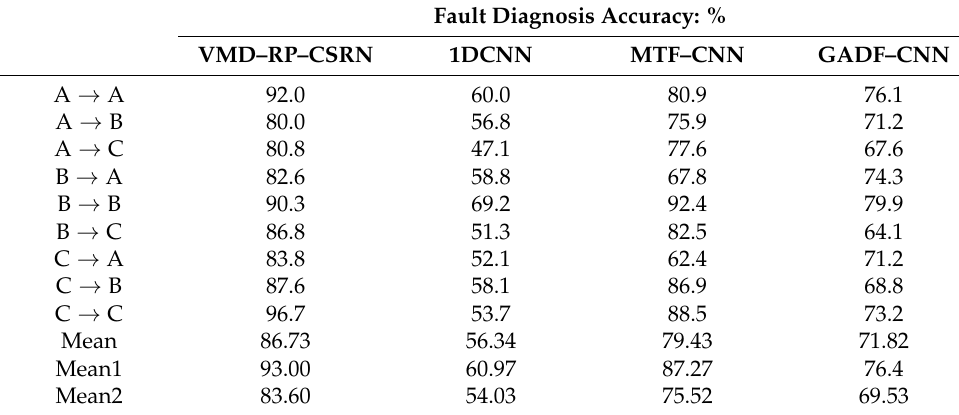
Table 5. Experimental results of model diagnosis at 10% training set